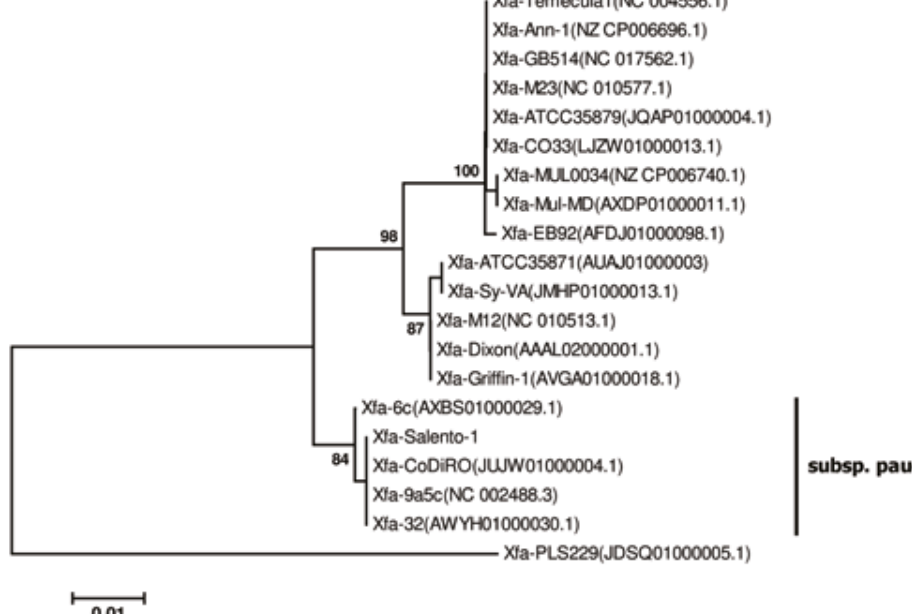
(one strain) and periwinkle (one strain), have been typed as ST53, according to the MLST database re- cords (http://pubmlst.org/xfastidiosa). Nucleotide